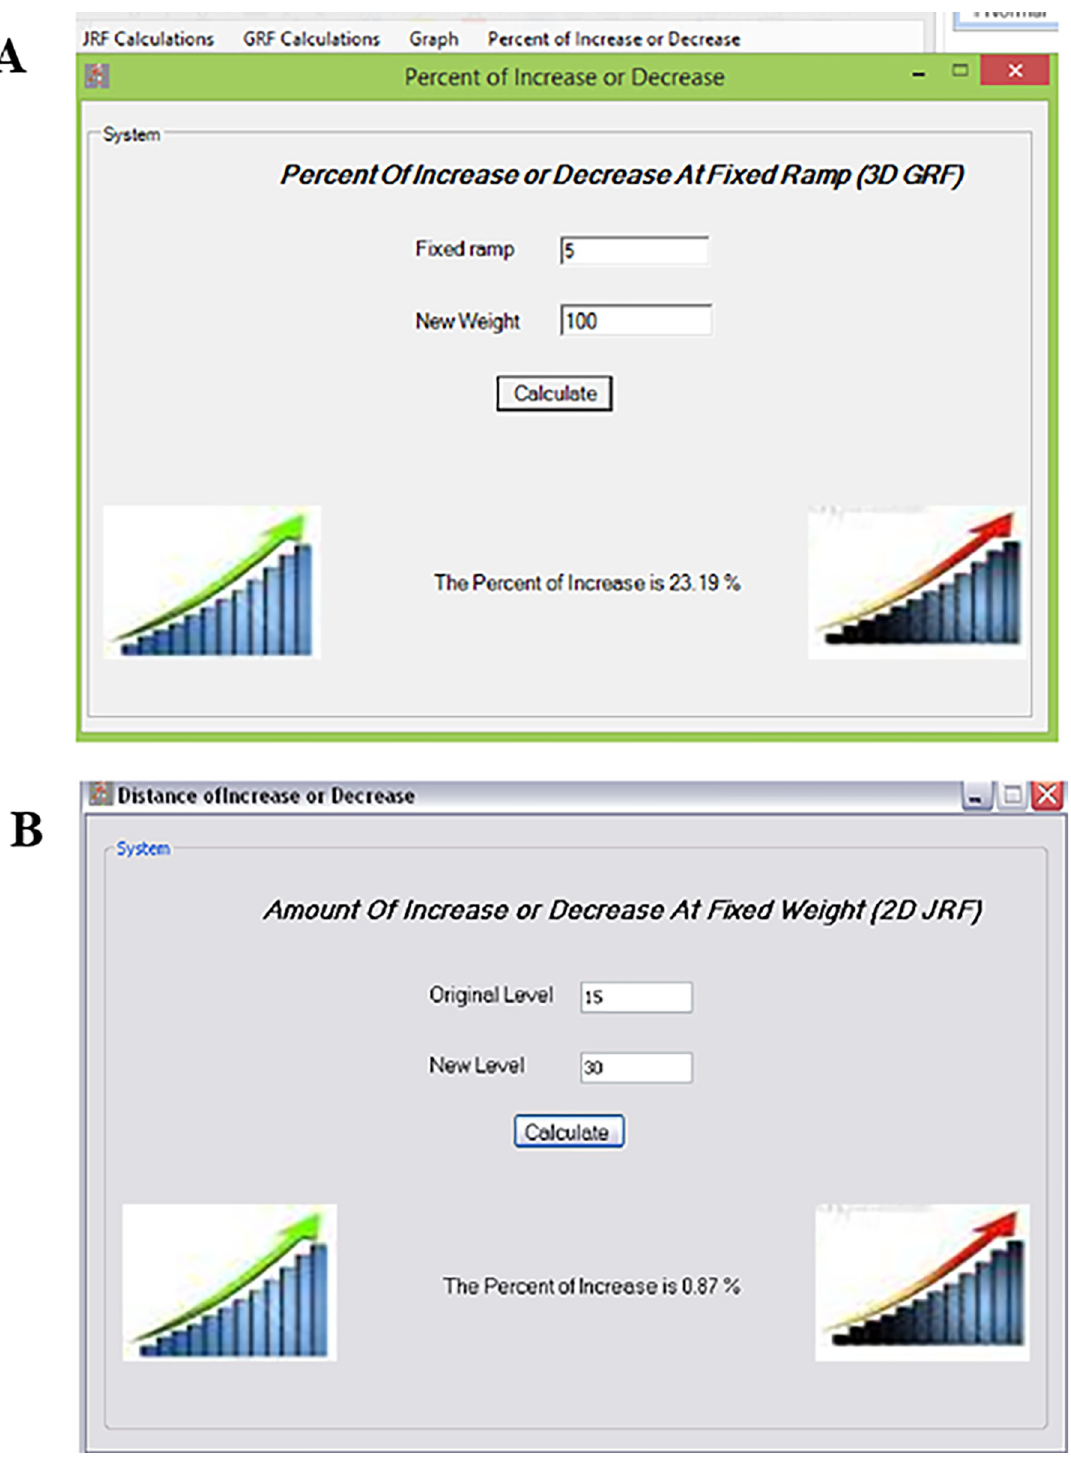
Fig 11. The windows show the final results reflecting the increase or decrease in the GRF and JRF calculations. (A) The percentage of increase or decrease in GRF at fixed ramp can be observed in this window and (B) the amount of increase and decrease in the 2D JRF at fixed weight can be observed at the